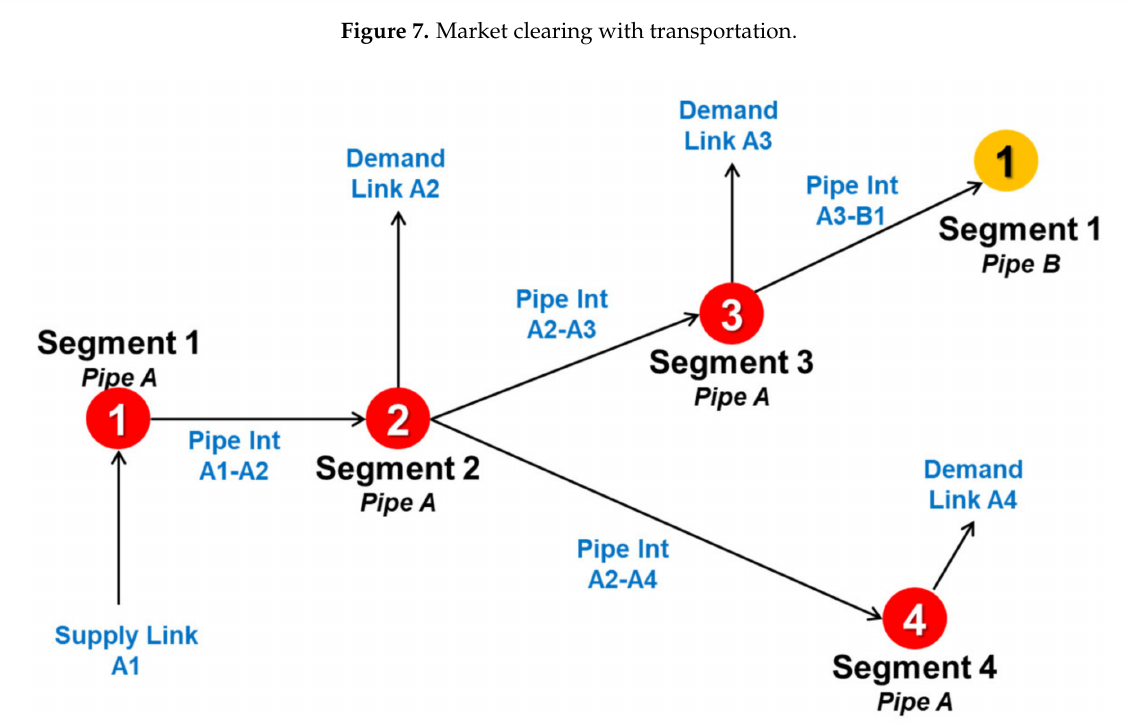
Figure 8. Pipeline network across